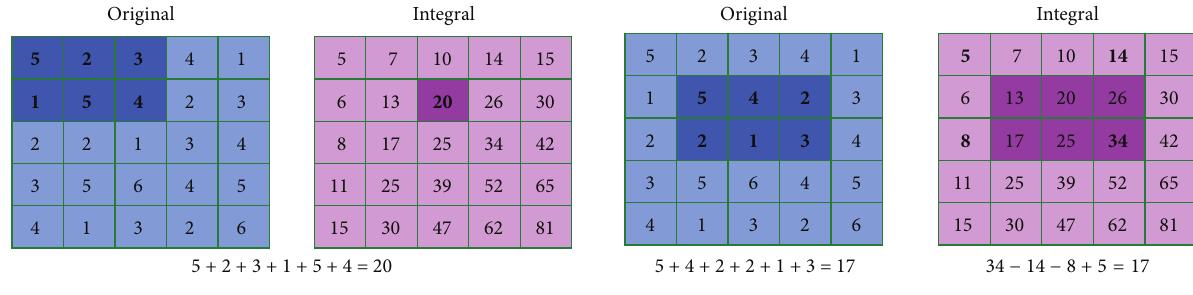
Figure 4: Integral image: illustration example.